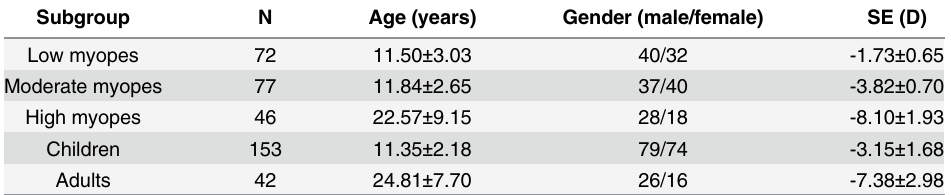
Table 2. The demographic data of low, moderate and high progressing